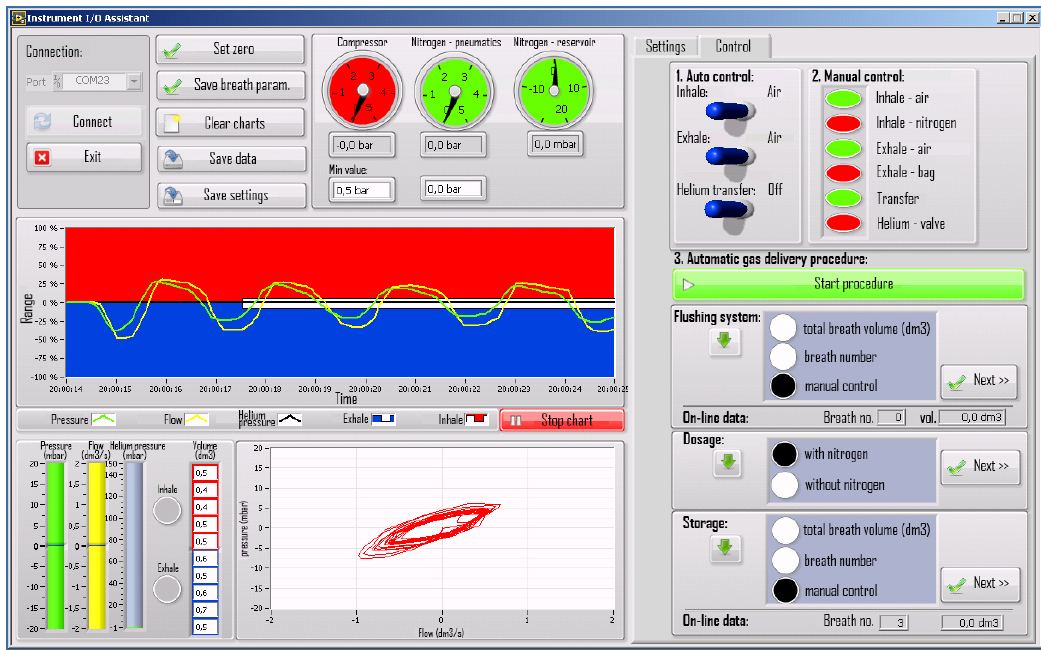
Figure 2. GUI of the program for the ventilator monitoring and control.